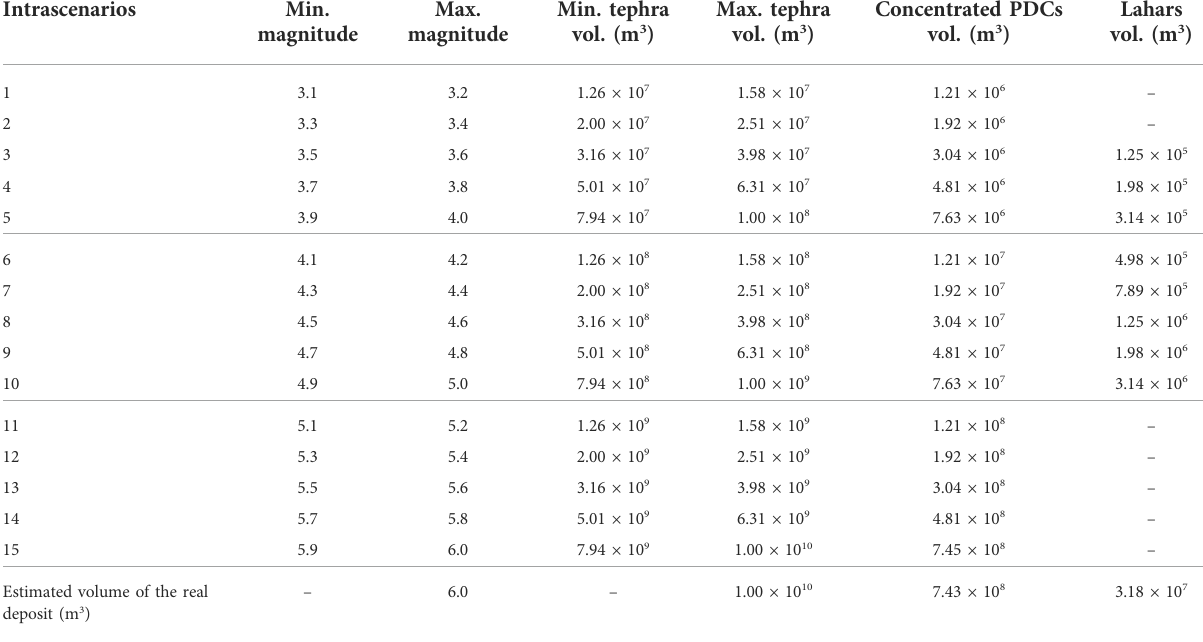
TABLE 1 The volumes and magnitudes of the explosive volcanic phenomena simulated in this study.